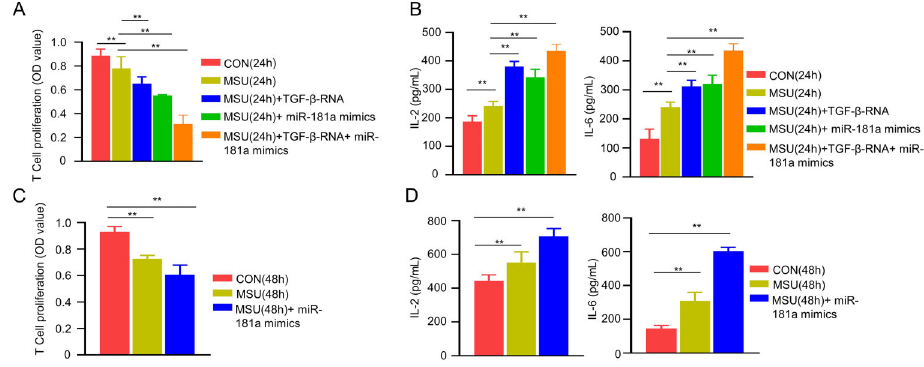
Figure 4. miR-181a regulates the suppressive activity of Tregs. A , CD4 + CD25 + Tregs isolated from control (CON) or monosodium urate (MSU)-induced mice at 24 h were co-cultured with CD4 + CD25 (cid:3) T lymphocytes, in the presence or absence of TGF- b 1 and miR-181a overexpression. The proliferation of CD4 + CD25 (cid:3) T lymphocytes was determined by CCK-8 assay. B , Interleukin (IL)-2 and IL-6 cytokine levels were measured in Tregs under the conditions described in ( A ). C , CD4 + CD25 + Tregs isolated from both groups at 48 h were co-cultured with CD4 + CD25 (cid:3) T lymphocytes, in the presence or absence of miR-181a overexpression. The proliferation of CD4 + CD25 (cid:3) T lymphocytes was determined by CCK-8 assay. D , IL-2 and IL-6 cytokine levels were measured in Tregs under the conditions described in ( C ). Data are from three independent experiments. Data are reported as means ± SD. **P o 0.01